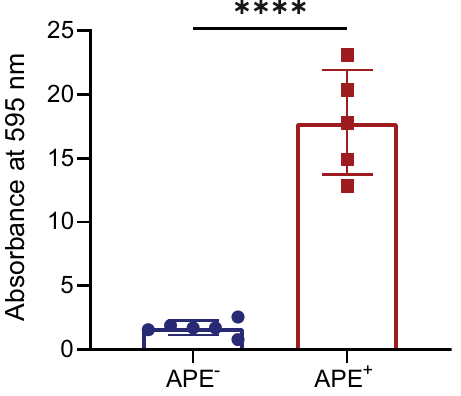
Fig. 6 APE Ec expression increases E. coli bio fi lm formation. Bio fi lms were grown in non-treated multi-well plates for 48 h and subsequently stained with crystal violet. Absorbance at 595 nm was measured and normalized to APE - values ( n = 3 repeats; error bars represent SD; **** p < 0.0001 by unpaired, two-tailed t